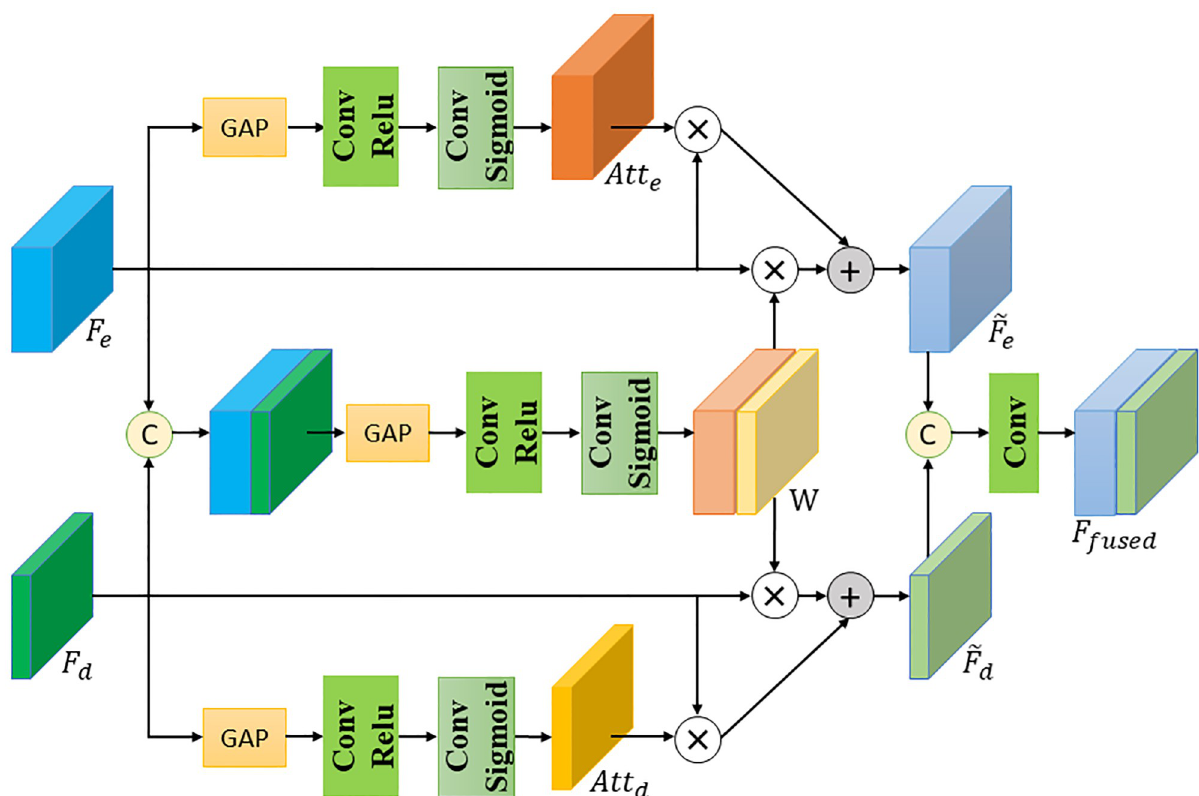
Fig 4. The architecture of the proposed multi-level feature fusion module. The GAP denotes the global average pooling operation. The Conv in MFFM is all 1 × 1 convolutional layer.